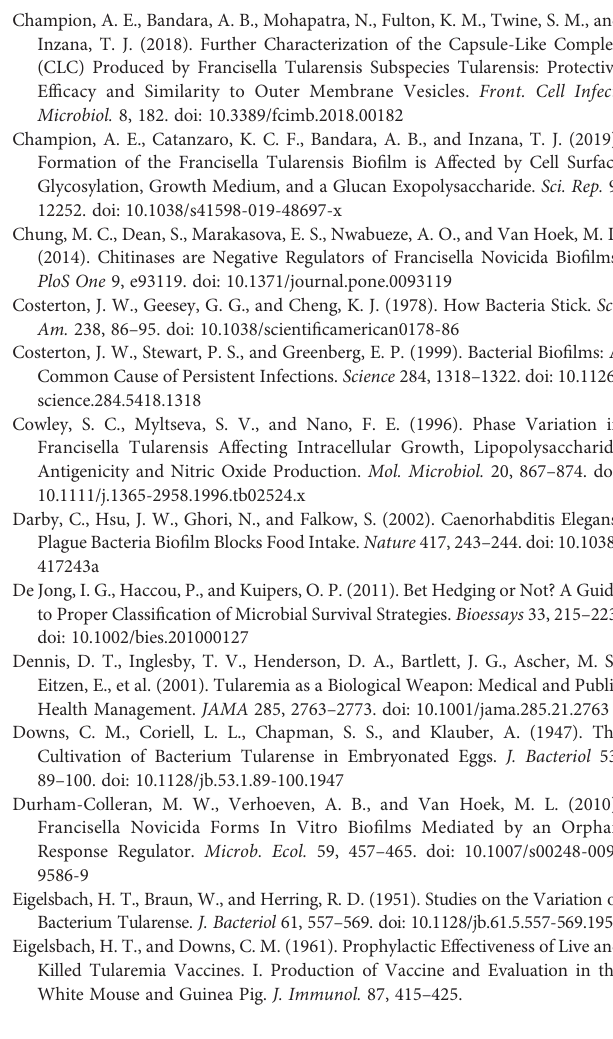
Supplementary Figure S5 | OD 600 Growth values of statically grown bio fi lm plates. The OD 600 values obtained after over the course of 7 d static incubation in CDM are displayed. Black bar indicates the median value. Supplementary Figure S6 | Diverse colony morphologies are observed upon streaking cultures that formed bio fi lm. LVS and bio fi lm positive (Population 25) were streaked on chocolate agar and grown for 3 days at 37 o C. Representative images are shown. Black arrow indicates large colony morphology, similar to wild-type while red arrows indicate the small colony morphology observed in grey variants. Supplementary Figure S7 | Diagram of the work fl ow used to identify bio fi lm positiveisolatesinthisstudy. F.tularensis (LVS)wasculturedinCDMfor7d.Priorto staining, a glycerol stock was made from the contents of each well. (A) Wells identi fi ed as bio fi lm positive were assayed for bio fi lm formation at 3 d. Each bar represents the OD 600 value corresponding to crystal violet straining of a bio fi lm positive population of bacteria obtained from independent experiments. Error bars represent SEM for 3 independent experiments. (B) Bio fi lm positive populations were streaked onto chocolate agar and incubated for 3 d to allow well de fi ned colonies to appear. (C) Isolated colonies chosen at random from these populations were then inoculated in CDM and incubated again for 3 d. Prior to crystal violet staining, glycerol stocks were made to preserve the bacteria in each well. (D) Wells identi fi ed as bio fi lm positive were streak puri fi ed to obtain constitutive bio fi lm forming isolates. This process was used to obtain puri fi ed bio fi lm forming isolates in the LVS, FRAN244 and FRAN255